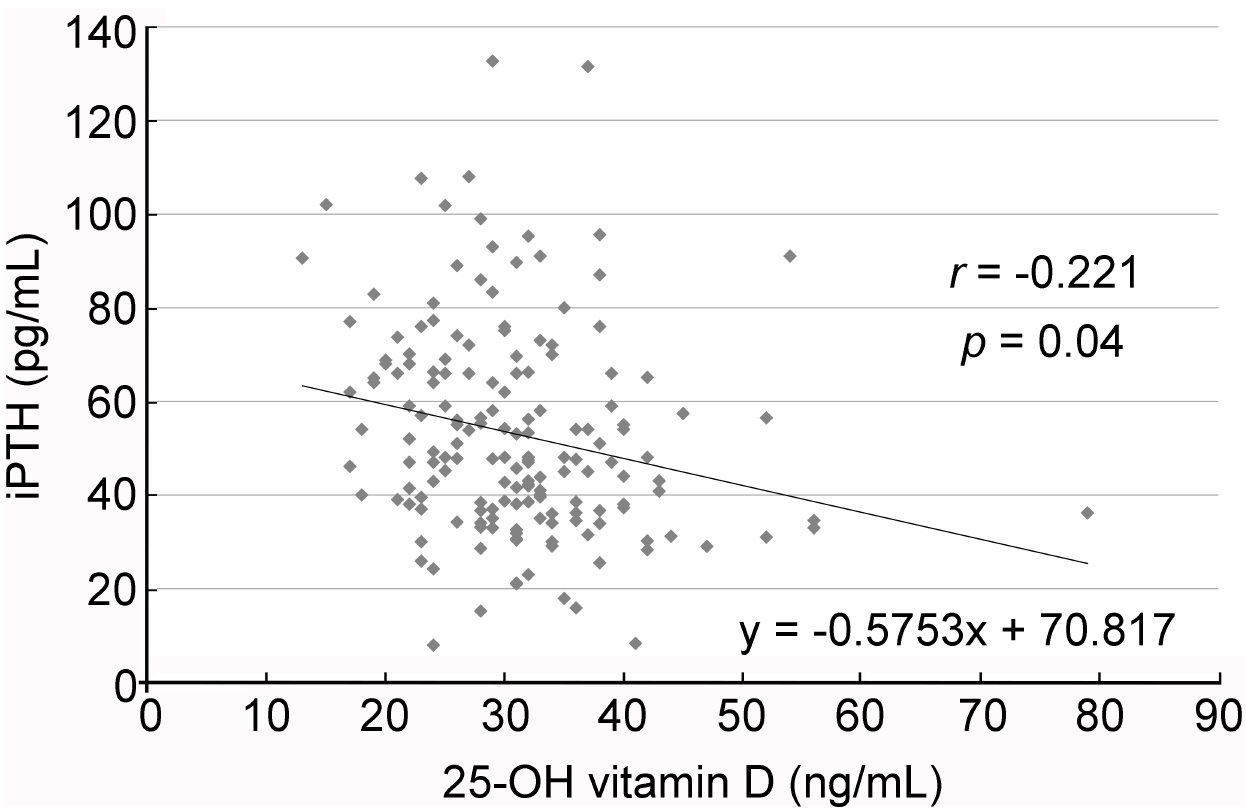
Fig 2. Relationship between serum parathyroid hormone (iPTH) concentration and 25-OH vitamin D level. Regression analysiswith scatter plot showinginverse relationship betweenserum iPTH concentration and that of 25-OH vitamin D.